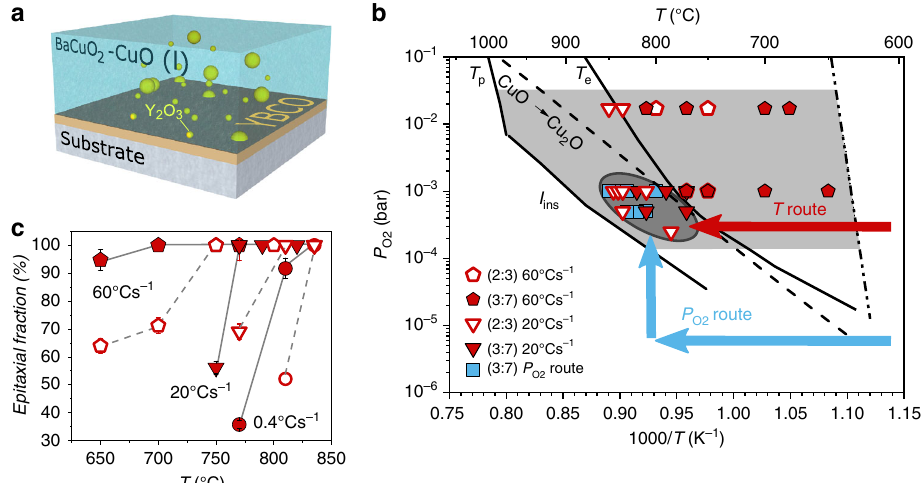
Fig. 1 Transient liquid-assisted growth (TLAG) principles. a Schematic drawing of the TLAG process. b T – P O2 phase diagram for YBCO TLAG growth. The 2BaCuO 2 -CuO eutectic temperature, T e , the YBCO peritectic temperature, T p , and the instability YBCO line, I ins , are shown. The T-route and P O2 -route are indicated by arrows. Symbols are the fi nal temperature and P O2 values of individual experiments: open symbols (2BaCuO 2 -CuO, 2:3 composition) or closed symbols (3BaCuO 2 -4CuO, 3:7 composition) in red (T-route) or blue (P O2 -route); all symbols indicate 100% epitaxial growth. T e has been determined from ref. 27 and this article (see details in methods); T p , T ins , and the CuO-Cu 2 O line are from ref. 10 . c Epitaxial fraction dependence on growth temperature for the T-route at different heating rates for 2:3 (empty symbols) and 3:7 (solid symbols) compositions at P O2 = 10 − 3 bar. Error bars indicate the accuracy of the method as determined in ref. 7